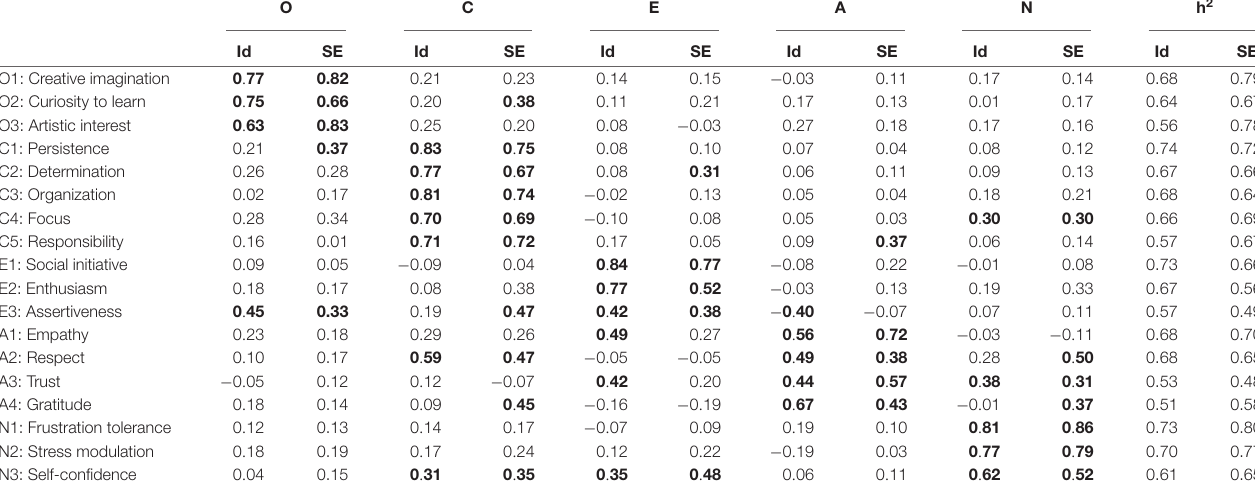
TABLE 5 | Separate factor structures for the trait-identity item clusters (Id) and for the self-efficacy (SE) item clusters: Standardized loadings from a principal component analysis after controlling for acquiescence and communality (h 2 ) to indicate total variance explained. O